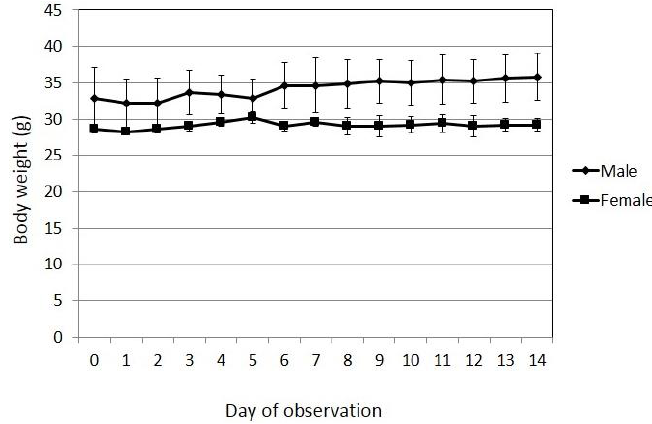
Figure 5. Fluctuation in the body weight of the test mice.